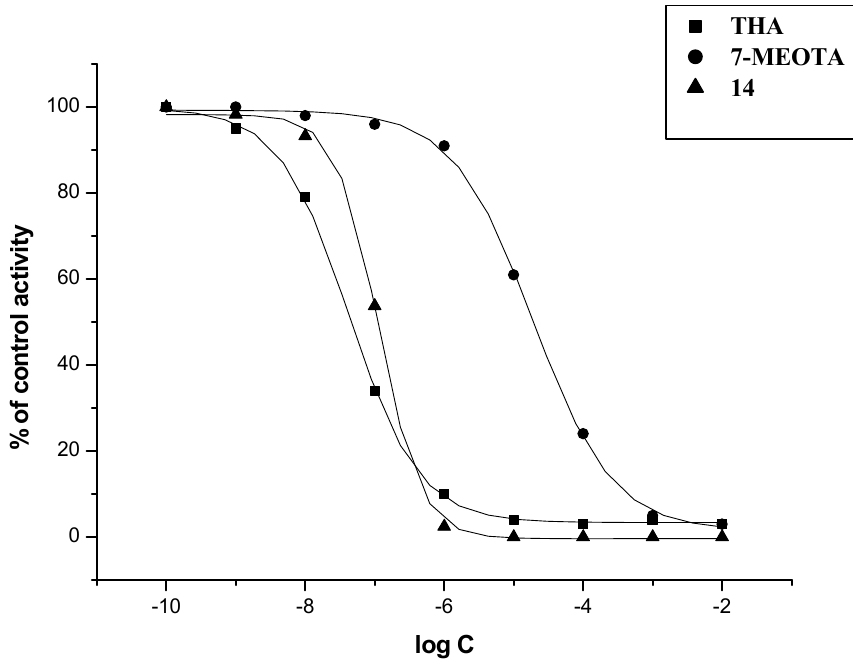
Figure 4. Enzyme activity plot of THA, 7-MEOTA and 14 for